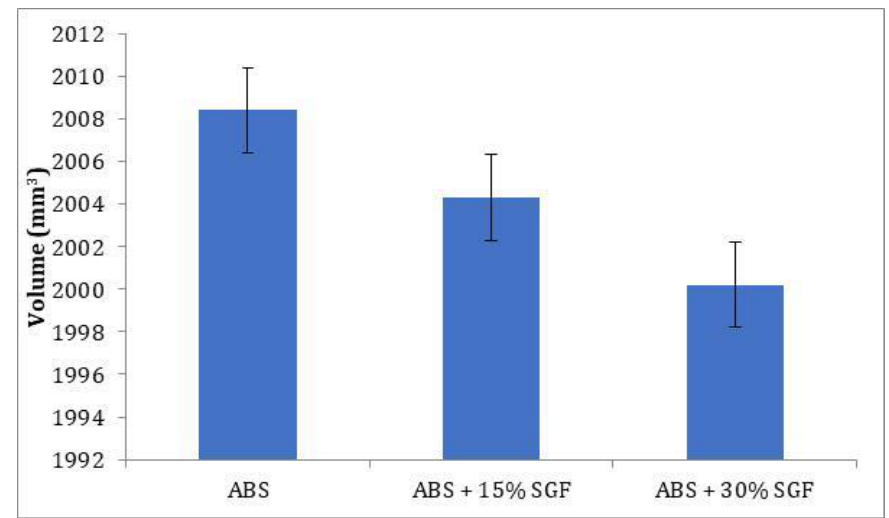
Figure 8. Variation of volume with addition of short glass fibre.